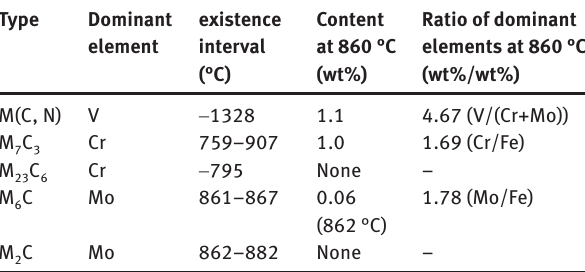
Table 4: Related data of carbides in H13 steel by ThermoClac